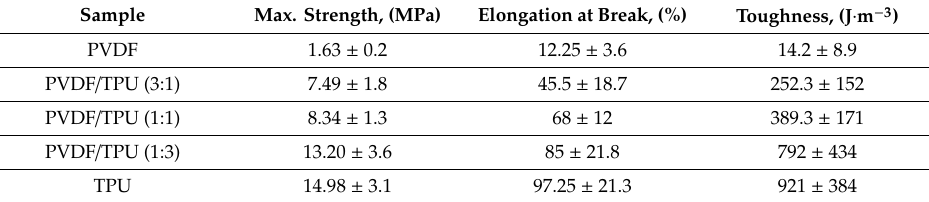
Figure 5. Stress strain curve of PVDF: TPU composite nanofiber. Table 2. Mechanical Properties of Nanofibrous Composites Membranes.